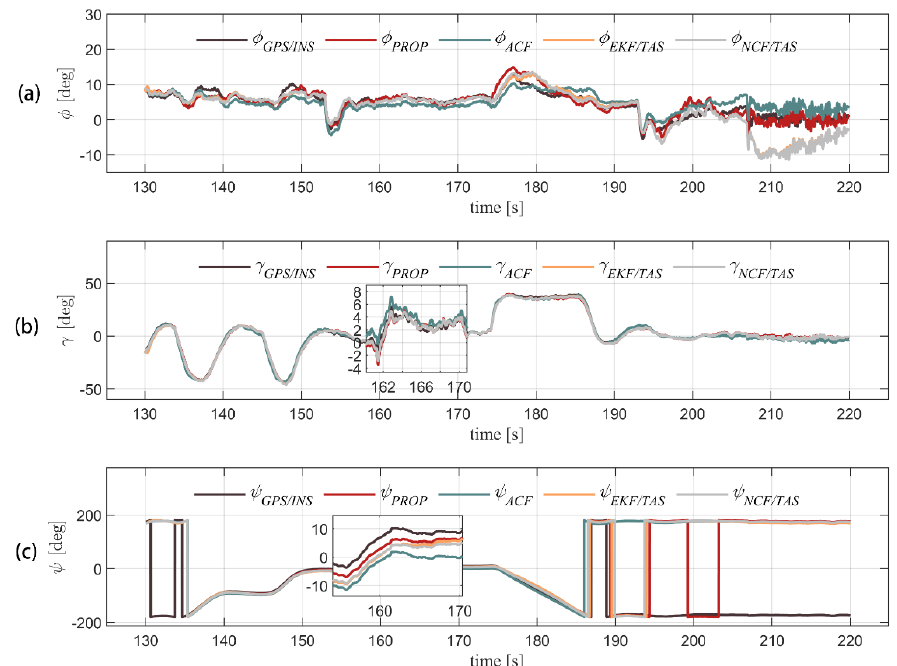
Figure 6. Three-axis attitude solution of five algorithms in flight is shown for pitch, roll, and yaw angle (from ( a – c ), respectively).